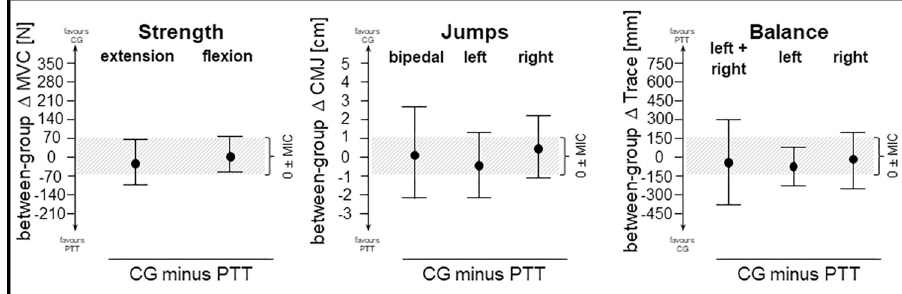
Fig 4. Functional outcomes. Plots show adjusted between-group effects of ANCOVA (95% CI); negative values in strength and jumps and positive values in balance represent beneficial effects towards PTT (perturbation-based trunk stabilization training) over CG (control group); grey shaded: Null ± MIC (minimal important change); MVC: maximal voluntary contraction, CMJ: counter movement